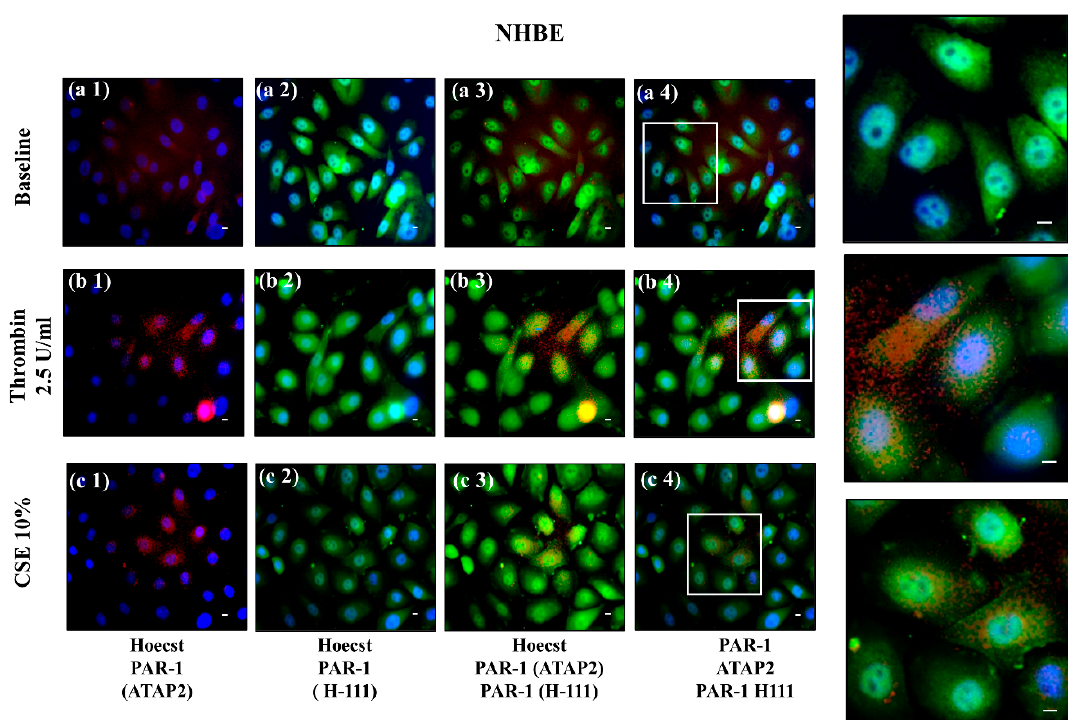
Figure 7. Active PAR-1 in NHBE. Evaluation of anti-PAR-1 ATAP-2 Ab, and anti-PAR-1 H-111 Ab localization and colocalization/distribution in NHBE cells stimulated with thrombin 2.5 U/mL and CSE 10% using immunofluorescence analysis. The stimulated cells were fixed and stained with anti-PAR-1 ATAP-2 Ab (red fluorescence) ( a1 , b1 , c1 ), and anti-PAR-1 H-111 (green fluorescence) Ab ( a2 , b2 , c2 ), and subjected to immunofluorescent microscopy. Cell nuclei were stained with Hoechst 33,342 (blue fluorescence). Anti-PAR-1 ATAP-2 and anti-PAR-1 H-111 abs colocalization/distribution was studied with ( a3 , b3 , c3 ), and without Hoeschst ( a4 , b4 , c4 ). The scale bar is 50 µ m. The magnification shows the co- localization/distribution of anti-PAR-1 ATAP-2 Ab and anti-PAR-1 H-111 Ab immunofluorescent staining. Nonimmune IgG was used as a negative control.